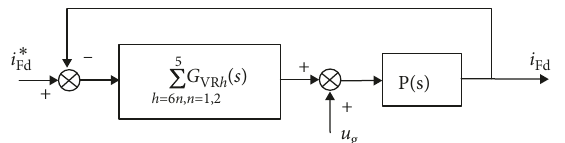
Figure 5: Current control block diagram when the system is disturbed by the grid